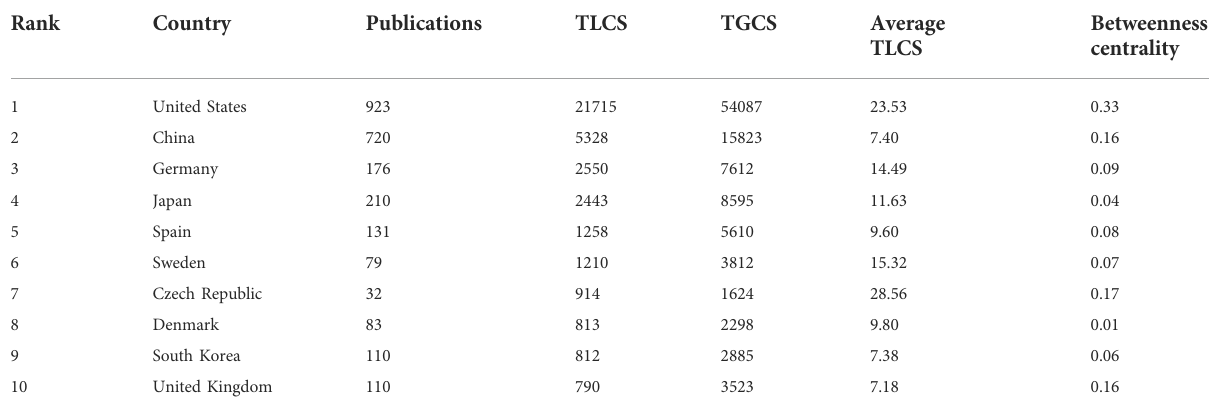
TABLE 1 Top ten countries with the highest TLCS.